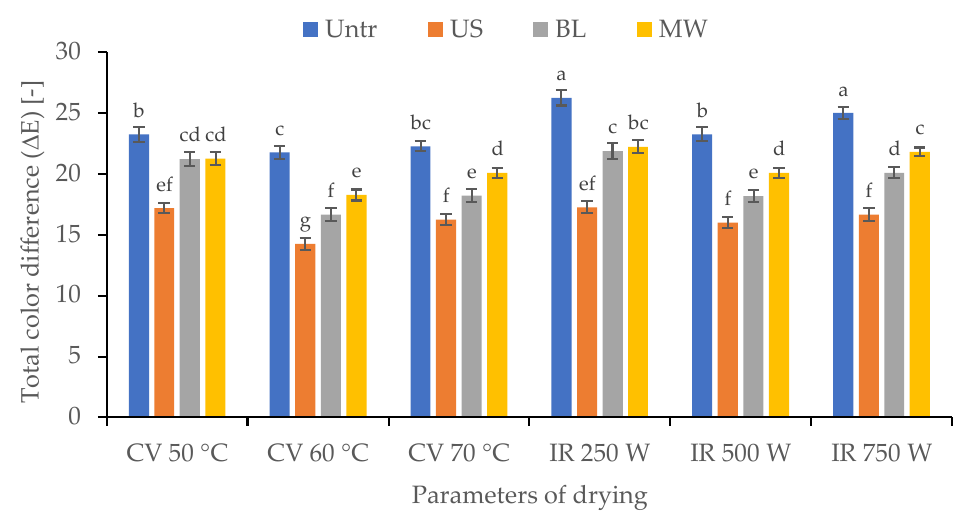
Figure 2. Effect of different pretreatments (Untr: control, US: ultrasonic, BL: blanching, MW: microwave) and different conditions of drying methods temperature (50, 60 and 70 °C) for CV drying and infrared power (250, 500, and 750 W) on the total color difference of dried terebinth. Bars show the differences between the sample with three replicates and the different letters differ significantly from each other at ( p < 0.05) as determined by the LSD test.